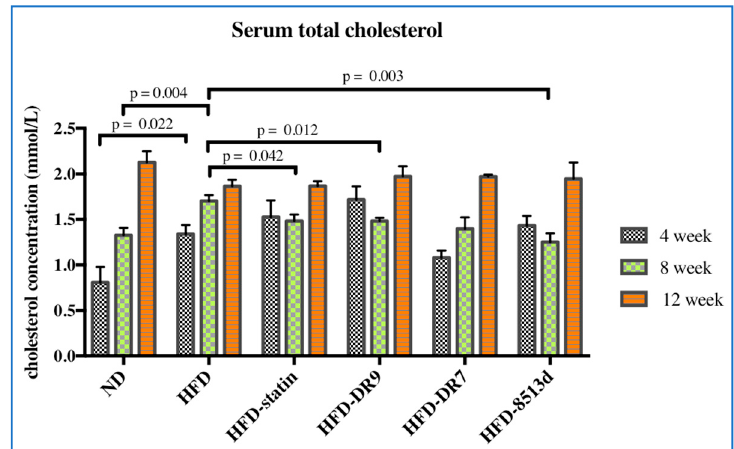
Figure 2. Serum total cholesterol in D-galactose-induced aging rats (600 mg/kg/day) after 4, 8, and 12 weeks of treatment. ND (normal diet), HFD (high-fat diet), HFD-statin (high-fat diet, receiving lovastatin 2 mg/kg/day), HFD-DR9 (high-fat diet, receiving L. fermentum DR9 (10 10 CFU/day), HFD-DR7 (high-fat diet, receiving L. plantarum DR7 (10 10 CFU/day), HFD-8513d (high-fat diet, receiving L. reuteri 8513d (10 10 CFU/day). Results are expressed as mean; error bars (SEM); n = 6. Statistical analysis was performed using independent t -tests.